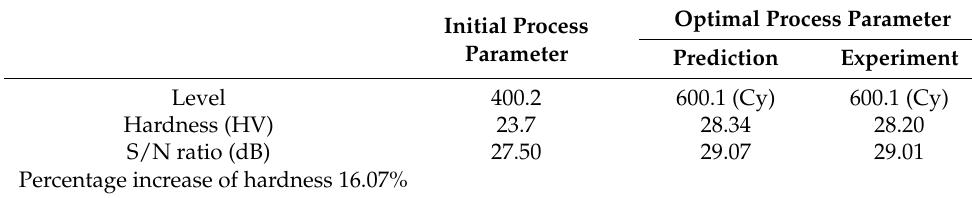
Table 13. Confirmation test results for